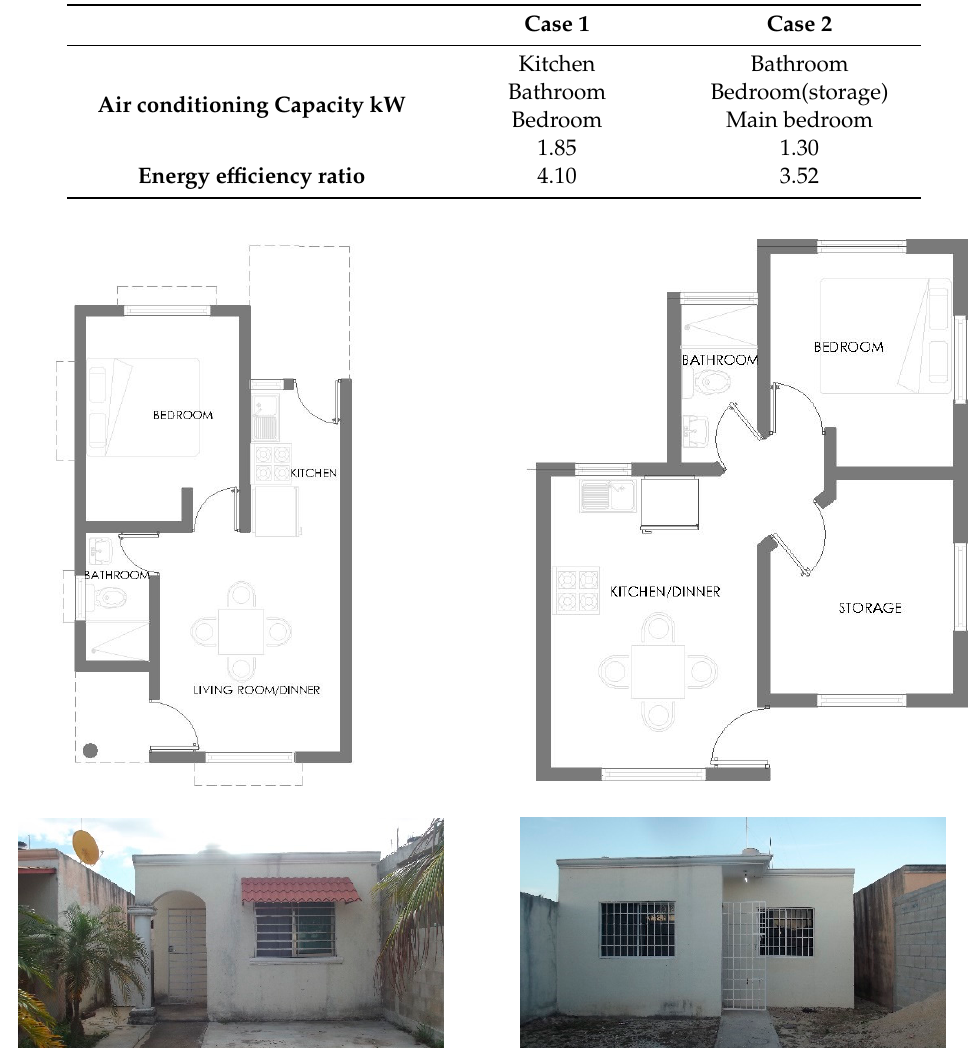
Figure 2. Case study #1 (left) and case study #2 (right)